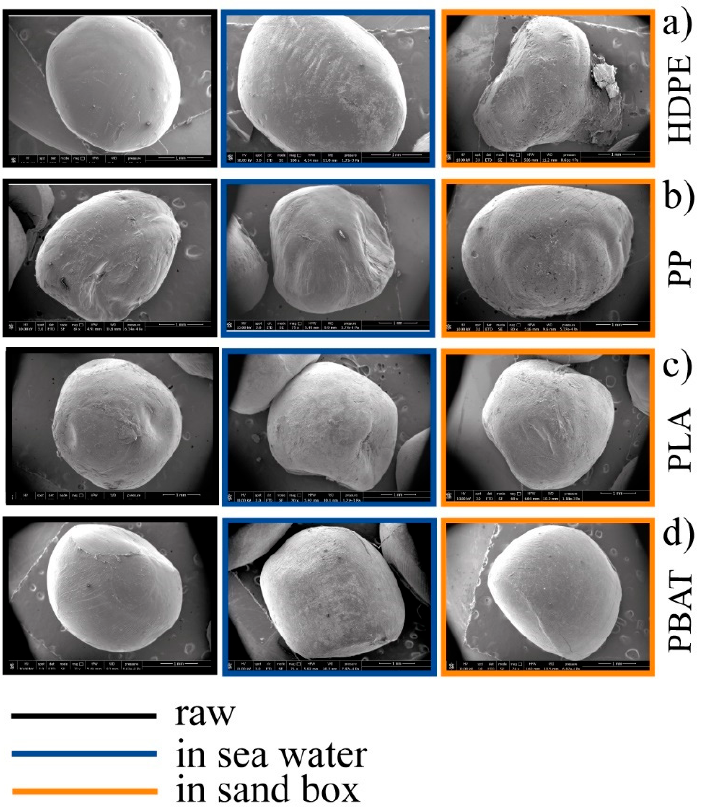
Figure 4. SEM images of the series ( a ) HDPE, ( b ) PP, ( c ) PLA and ( d ) PBAT: raw granules in black; 6 ‐ months ‐ aged in seawater in blue; 6 ‐ months ‐ aged in sandbox in orange.